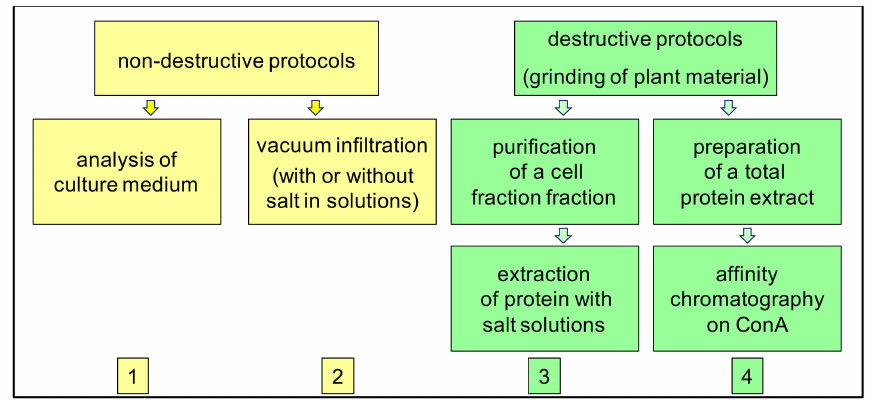
Figure 1. The four types of protocols (1–4) which have been used to study the extracellular proteome of plants. They can be qualified as non-destructive (1,2), or destructive (3,4), depending on whether they start with a grinding step or